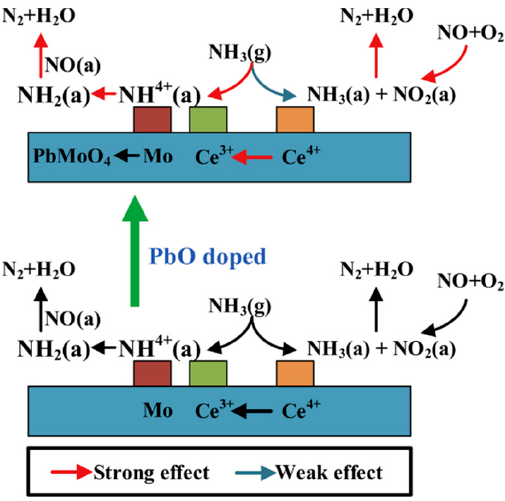
Figure 13. Diagram of PbO poisoning on CMT [71].